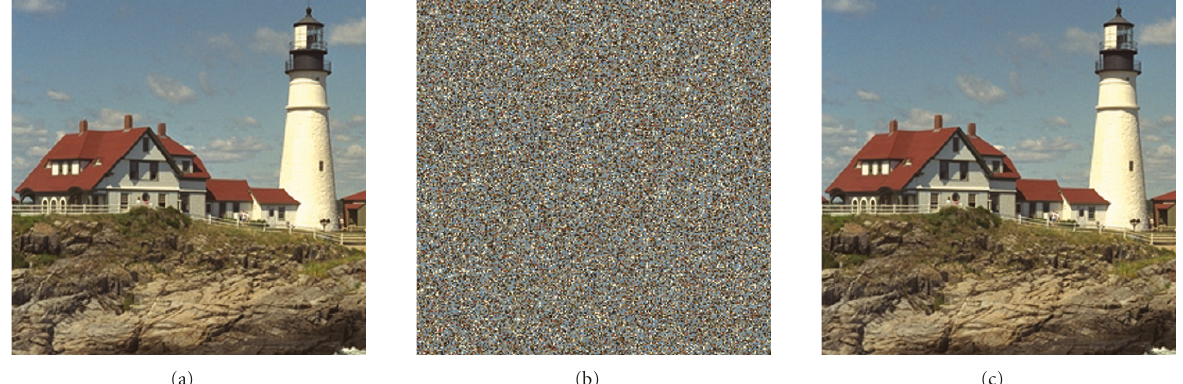
Figure 7: Visual impact of the proposed encryption-watermarking scheme for the image Lighthouse: (a) original image; (b) encrypted- watermarked image; (c) decrypted-watermarked image.